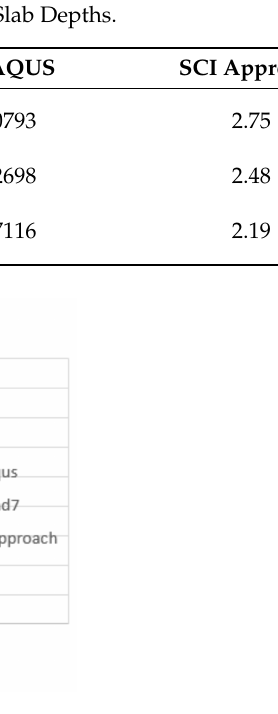
Figure 18. Comparison of Response Factor between Different Slab